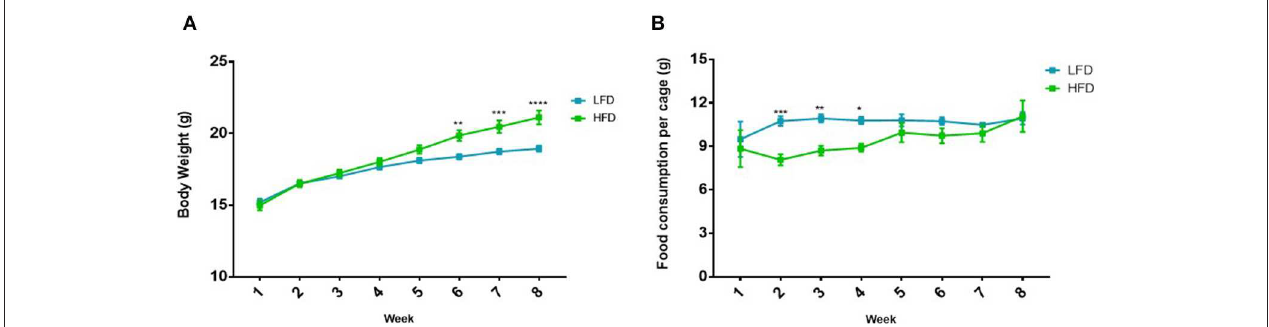
FIGURE 2 | Difference in (A) body weight and (B) food consumption in mice ( n = 5 per cage) on the LFD and HFD for 8 weeks. Results are presented as mean ± SEM ( n = 20 per group). T -tests were used for comparison between the LFD and the HFD mice for all weeks and p < 0.05 was considered as statistically significant.